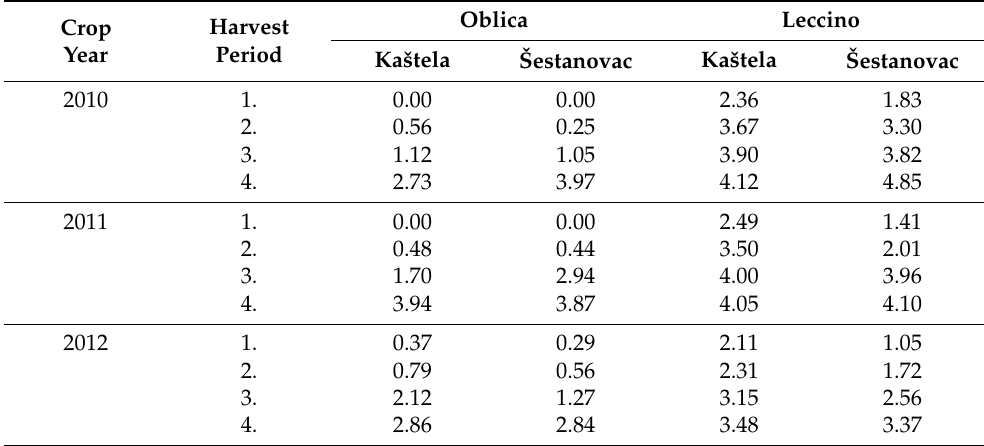
Table 1. Fruit maturity index of Oblica and Leccino cultivars grown in Kaštela and Šestanovac. Oblica Leccino Harvest Crop Period Year Kaštela Šestanovac Kaštela